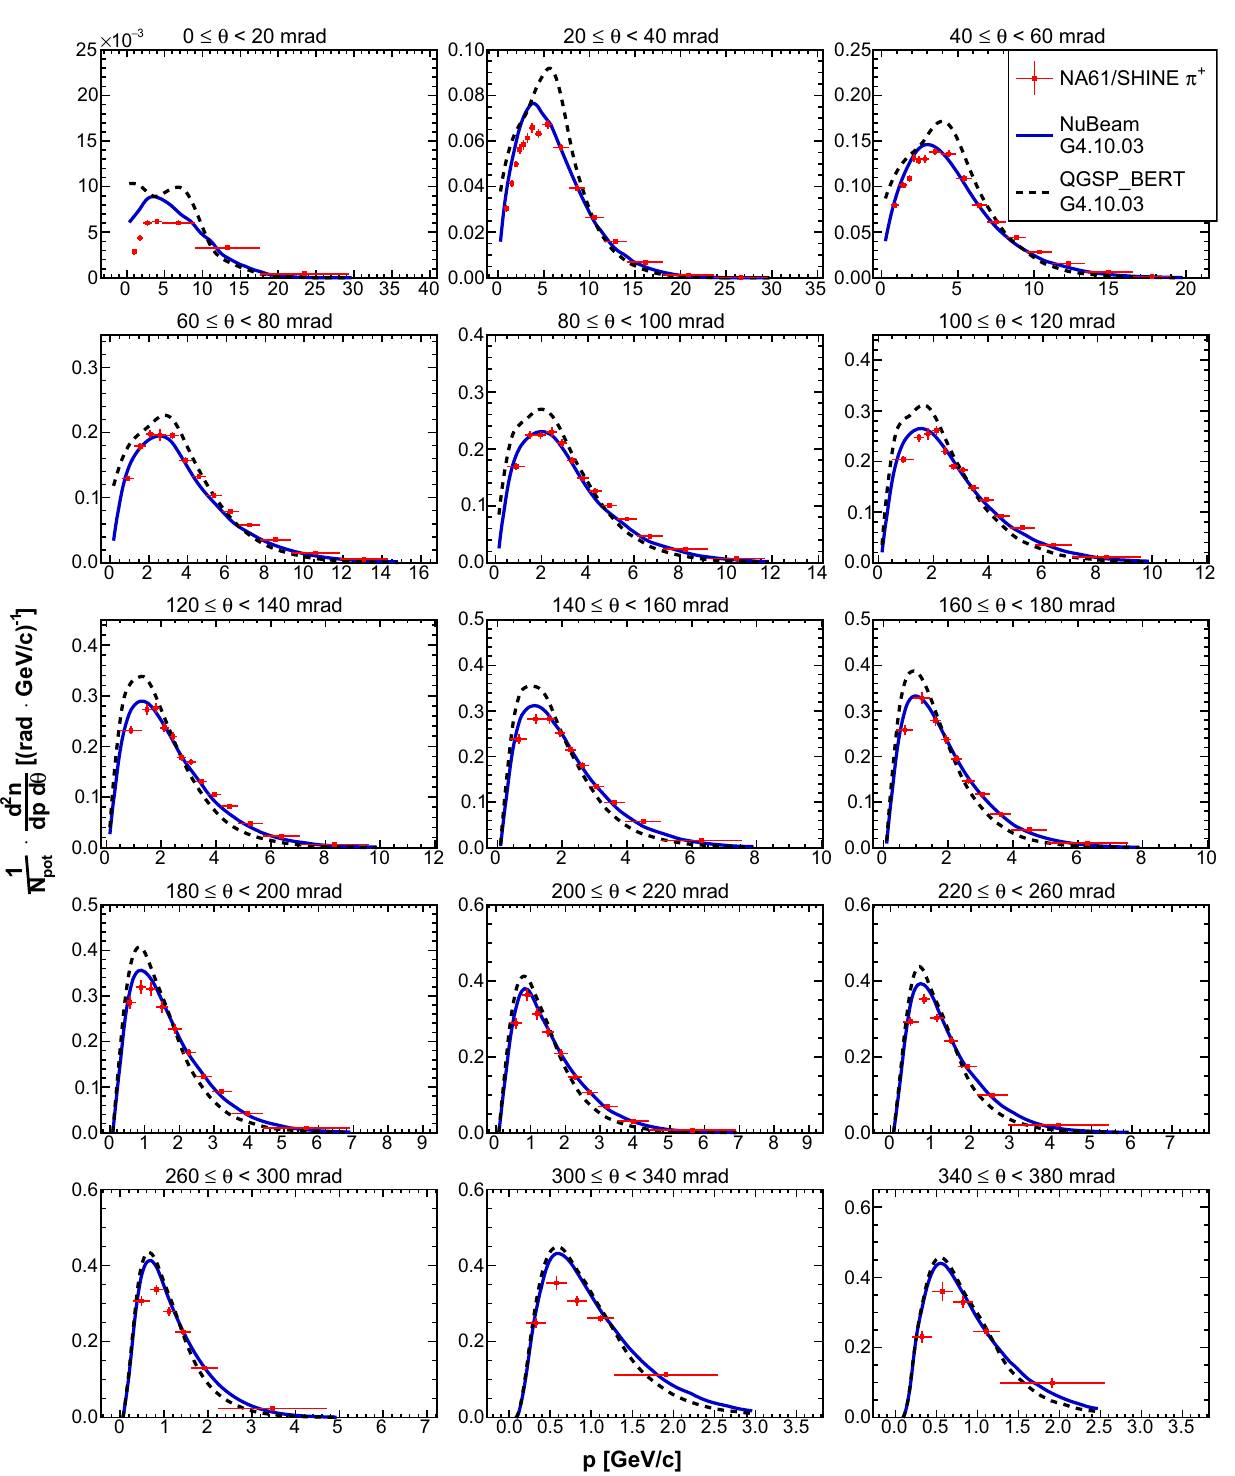
Fig. 26 Double differential yields of positively charged pions for the fourth upstream longitudinal bin (54 ≤ z < 72 cm). Vertical bars represent the total uncertanties. Predictions from the NuBeam (solid